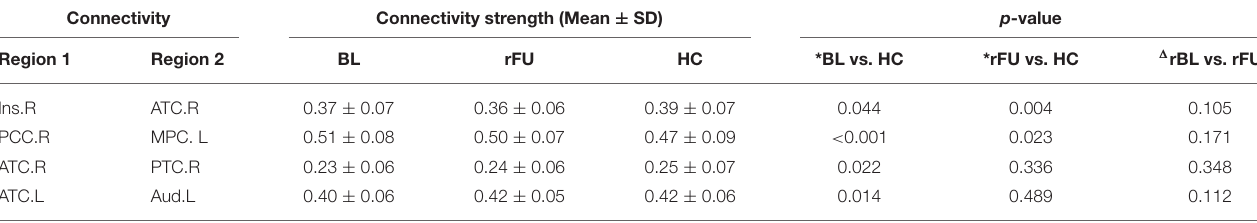
TABLE 3 | Association between the HAM-D 24 scores and four abnormal SCs in patients with MDD at baseline. Connectivity r p -value Region 1 Region 2 Ins.R ATC.R 0.03 0.77 PCC.R MPC. L 0.08 0.32 ATC.R PTC.R − 0.09 0.3 ATC.L Aud.L − 0.12